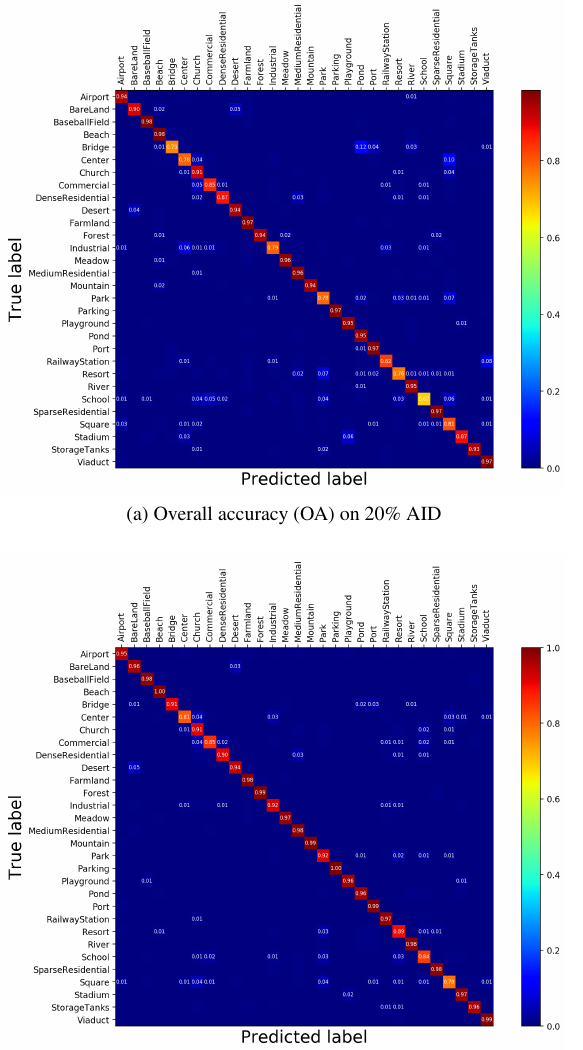
Figure 4. Confusion matrices of the best results achieved by PDN model on 20% and 50% AID respectively. Note that red represents better classification performance while blue means worse. Best view in color.